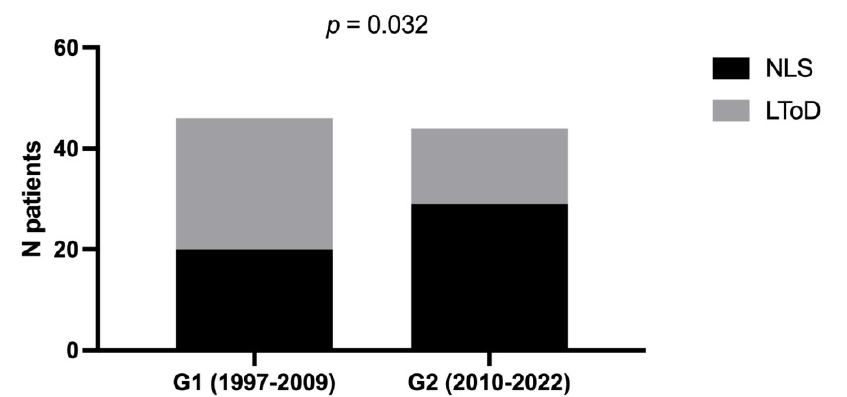
Figure 3. Comparison of the outcomes of patients with ALF according to era. LToD: liver transplant or death on waiting list. NLS: native liver survival; G1: group 1. G2: group 2.